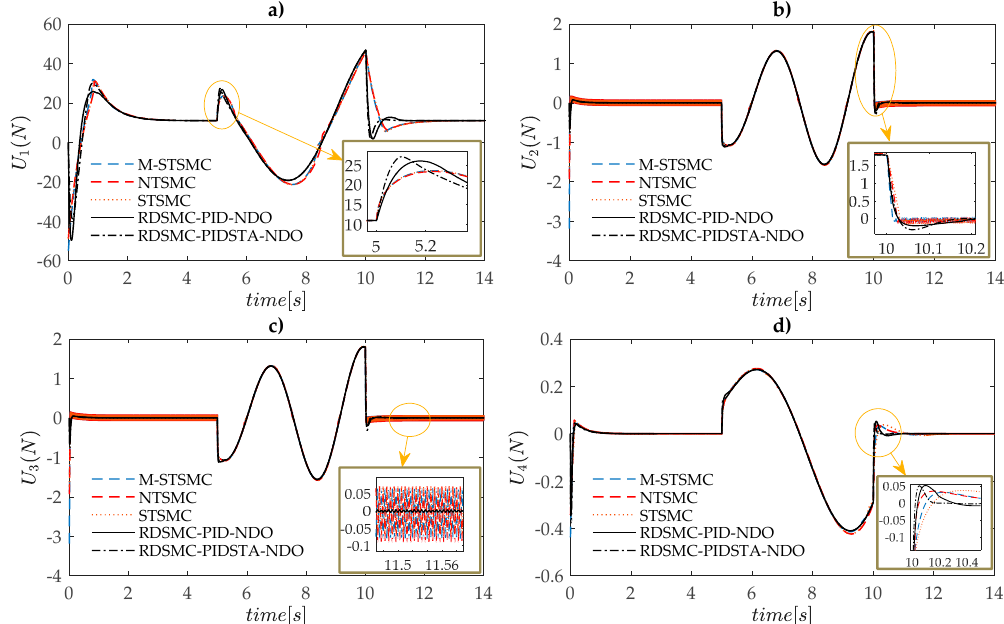
Figure 6. Comparison of attitude and altitude controller between the proposed RDSMC-NDO method and other approaches: ( a ) altitude controller U 1 ; ( b ) roll controller U 2 ; ( c ) pitch controller U 3 ; and ( d ) yaw controller U 4 .